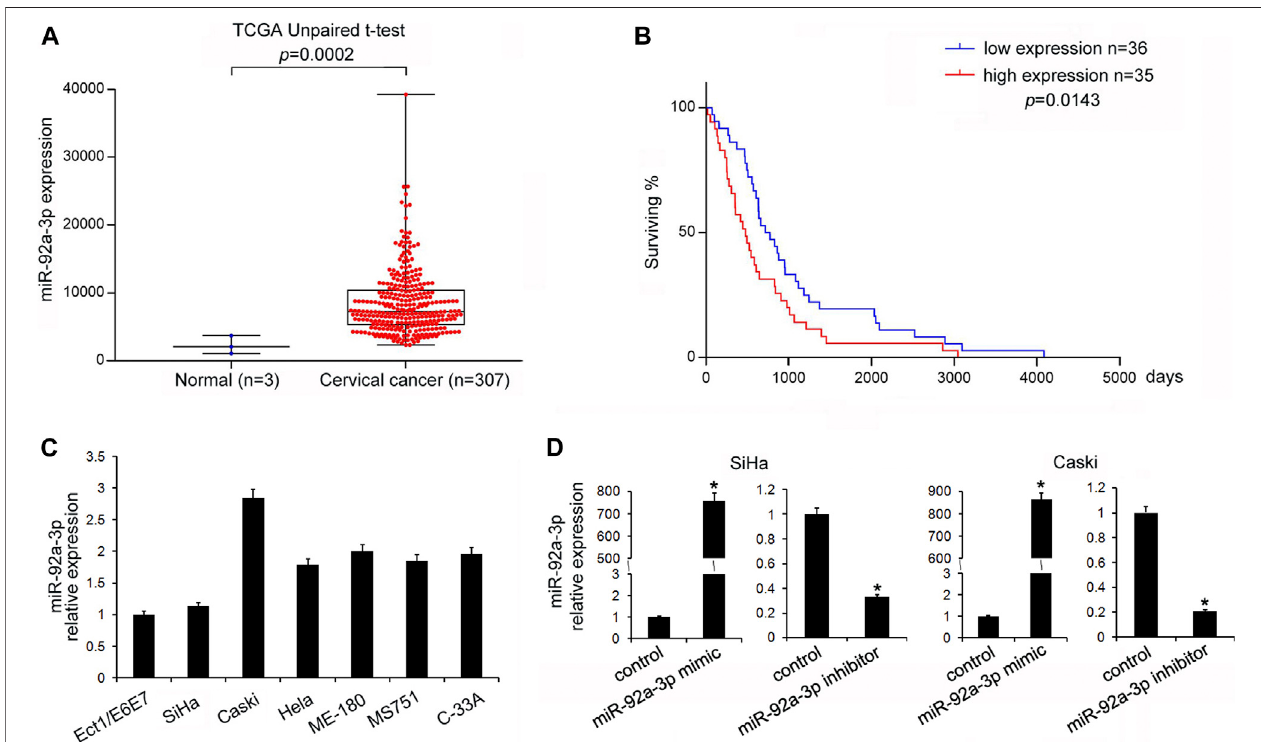
FIGURE1| miR-92a-3pwasupregulatedincervicalcancer. (A) AnalysisofTheCancerGenomeAtlasdatashowedthatmiR-92a-3pexpressionincervicalcancer (CC)tissueswashigherthanthatinadjacentnormaltissues( t -test, p (cid:2) 0.0002). (B) Kaplan-MeiersurvivalcurvesshowedthatpatientswithlowmiR-92a-3pexpressions hadbetteroverallsurvivalofthanthosewithhighmiR-92a-3pexpressions(log-ranktest, p (cid:2) 0.0143). (C) miR-92a-3pexpressionsinEct1/E6E7,Caski,SiHa,Hela,ME- 180,MS751,andC-33Acelllineswereexaminedusingquantitativereal-timePCR.miR-92a-3plevelsinCCstemcellswerehigherthanthoseinnormalcervicalcell lines (Ect1/E6E7). (D) RT-qPCR showed that miR-92a-3p expressions increased after miR-92a-3p mimic transfection in SiHa and Caski cells. The miR-92a-3p expression decreased after transfection of miR-92a-3p inhibitor in Caski cells. * p < 0.05.